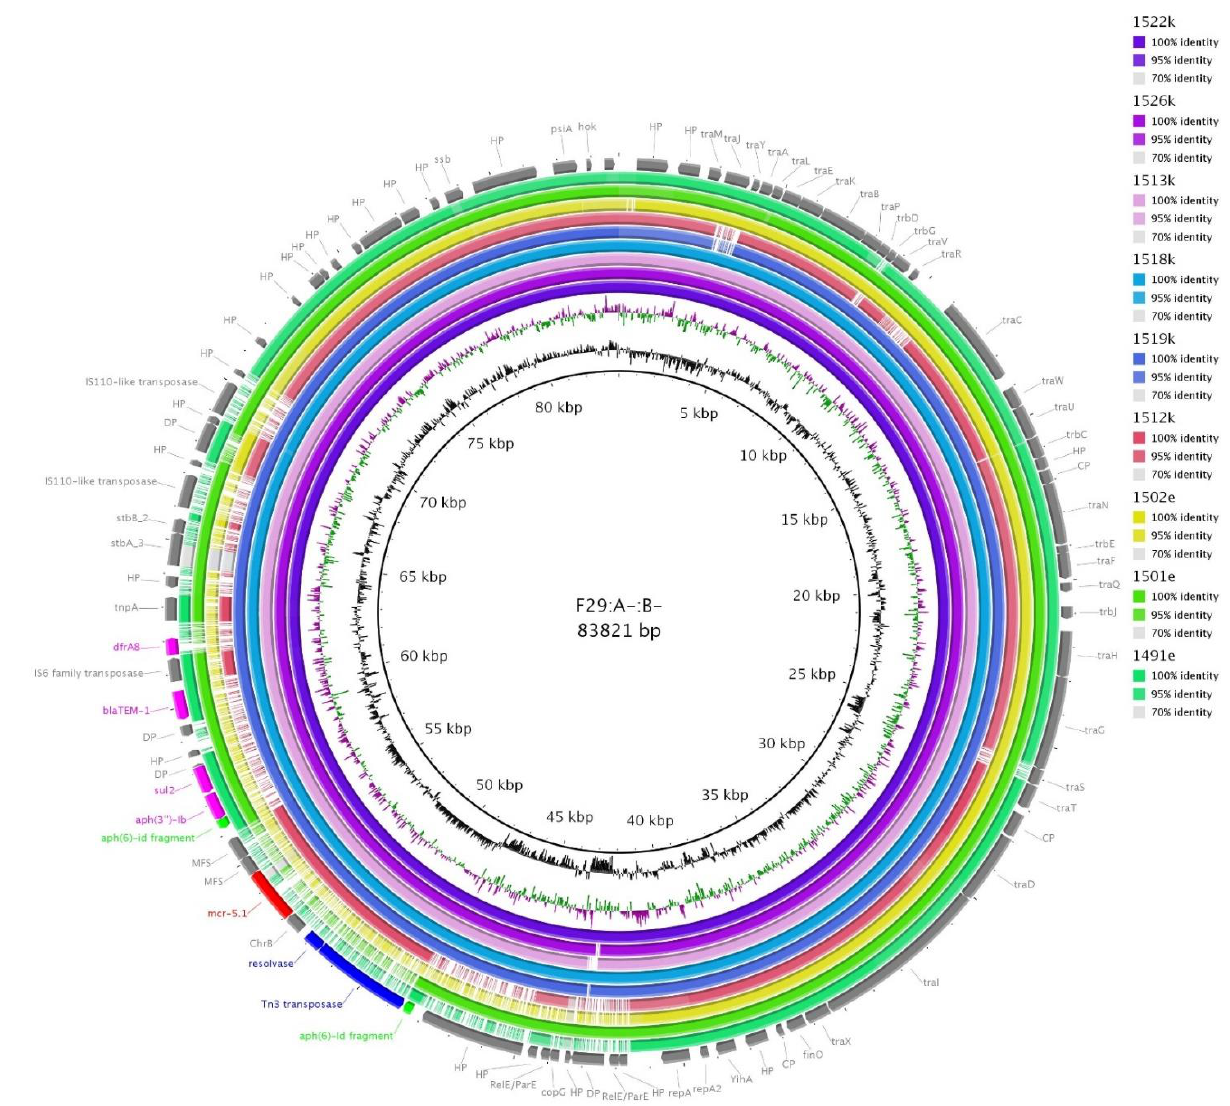
Figure 6. BRIG comparison of F29:A-:B- plasmids. Reference plasmid of F29:A-:B- was obtained from the 1522k strain (GenBank accession no. MW800637). Plasmids from the Paraguayan hatchery are depicted in purple, blue and red circles, while plasmids from the Brazilian hatchery are presented by the yellow and green circles. The transconjugants from the 1526k wild type strain was not evaluated using pulsed-field gel electrophoresis with S1 enzyme and PCR-based replicon typing because F replicon and mcr-5.1 gene was present within the same contig in WGS data, therefore mcr-5.1 was expected to be carried by F29:A-:B-. Antibiotic resistance genes are depicted in fuchsia, except mcr-5.1 (red), and fragmented aph(6)-Id gene (lime) which was considered to be non-functional. Mobile genetic elements of the transposon with mcr-5.1 are highlighted in